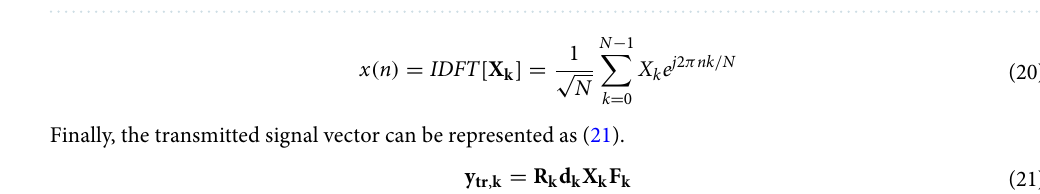
Figure 4. Block diagram of the proposed F-OWDM system for the k th